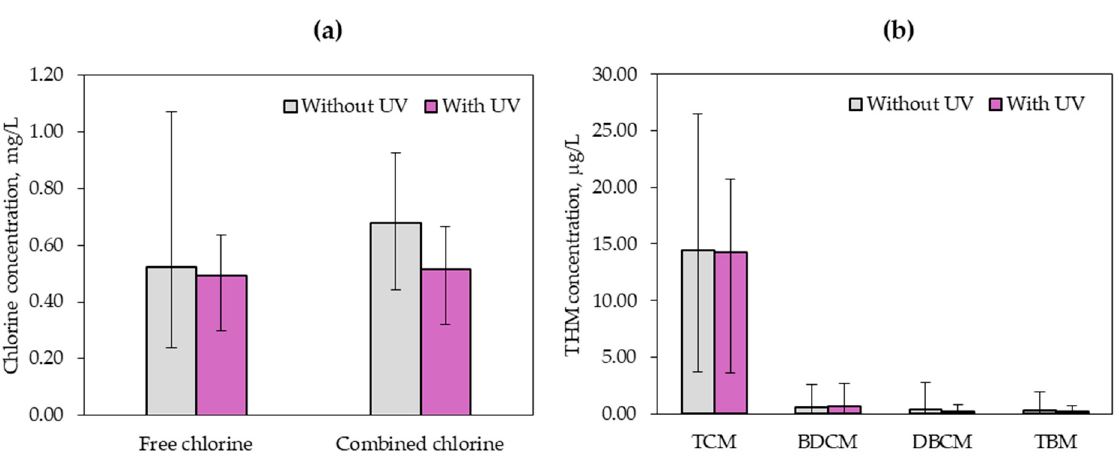
Figure 2. The average values of swimming pool water quality parameters with and without a UV lamp: ( a ) free and combined chlorine; and ( b ) trihalomethanes.